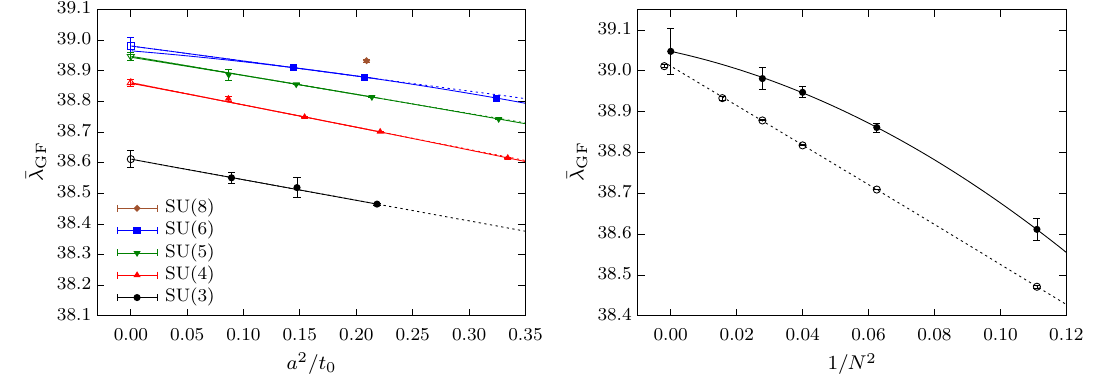
Fig. 3 Left: Continuum extrapolation of ¯ λ GF at t / t 0 = 0 . 8 for all the different gauge groups. Right: Large N extrapolations of ¯ λ GF in the continuum limit (solid line) and at finite lattice spacing, a 2 / t 0 = 0 . 2091, (dotted line). The points at finite lattice spacing have been slightly shifted for better legibility